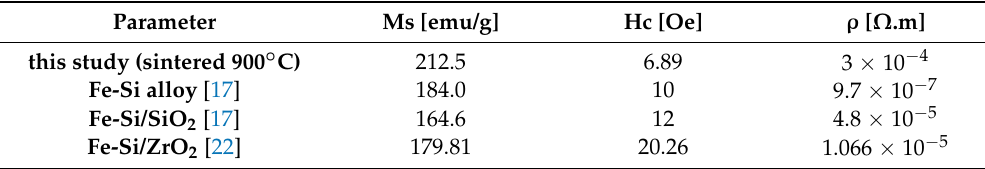
Figure 12. The Fe-Si/MnZn(Fe 2 O 4 ) 2 composite of the saturation magnetization (Ms) and coercivity(Hc) values.